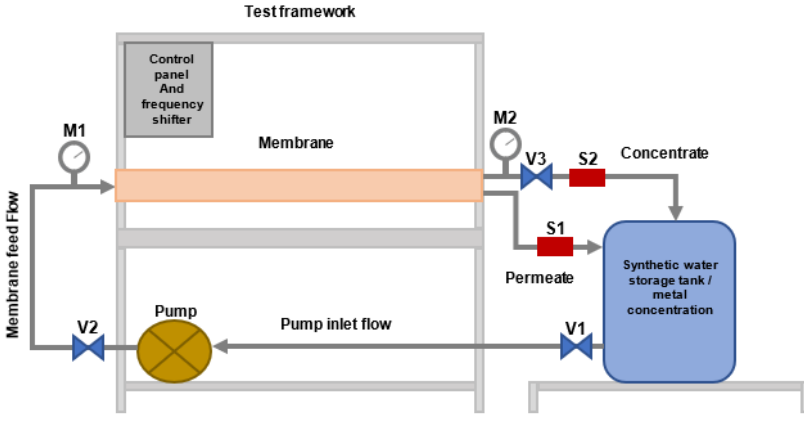
Figure 3. Scheme of the pilot experimental plant for RO [8].